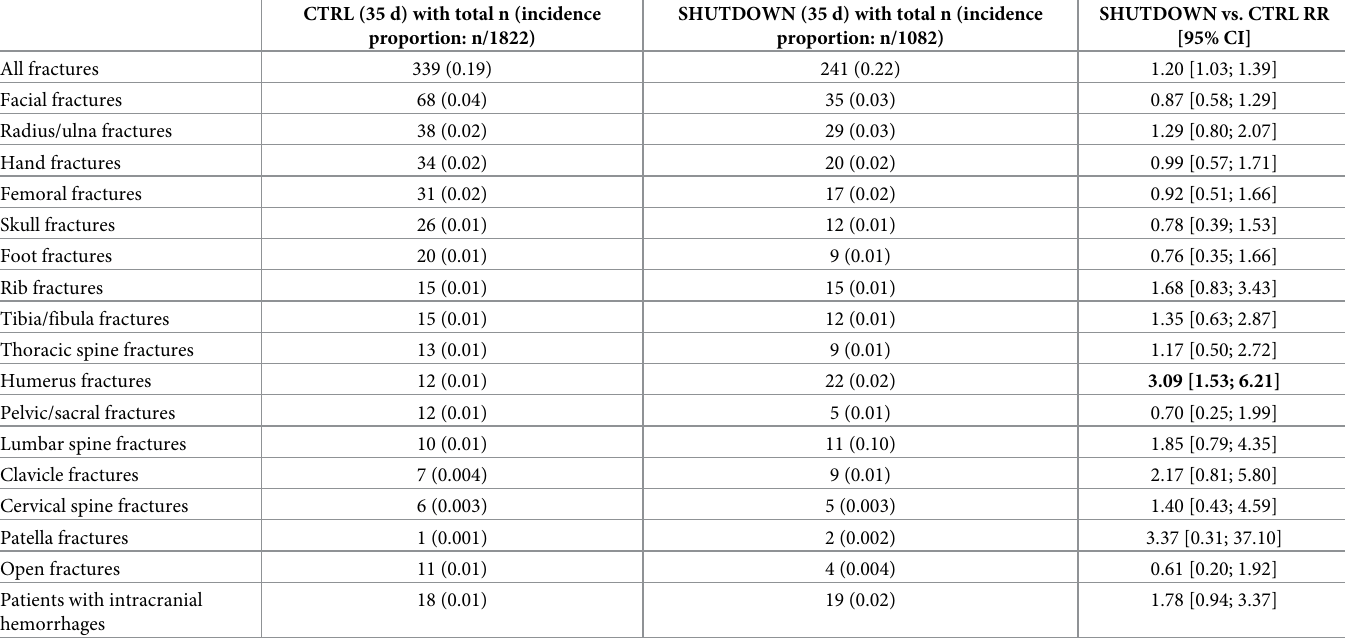
proportions of injured bicycle passengers increased during the SHUTDOWN compared to the CTRL period with an RR of 1.68 (SHUTDOWN vs. CTRL, 95% CI: [1.13; 2.51]). While the relative number of injuries sustained on the way to or from work decreased dur- ing the SHUTDOWN period with an RR of 0.46 (SHUTDOWN vs. CTRL; 95% CI: [0.27; Table 3. Total numbers, incidence proportions and RRs of different fractures and intracranial hemorrhages before (CTRL) and during the COVID-19 shutdown (SHUTDOWN) in Berlin, Germany. CTRL (35 d) with total n (incidence SHUTDOWN (35 d) with total n (incidence SHUTDOWN vs. CTRL RR proportion: n/1822) proportion: n/1082) [95%